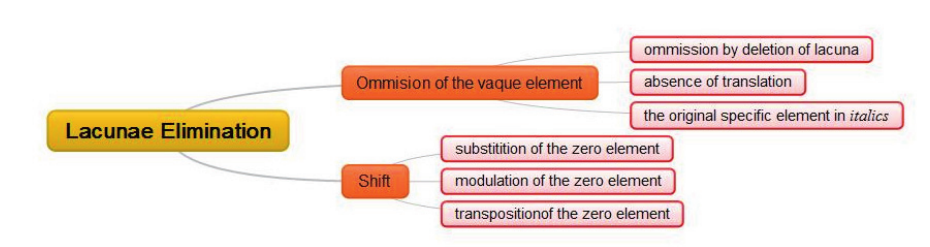
Fig. 3. The ways to deal with lacuna: omission vs